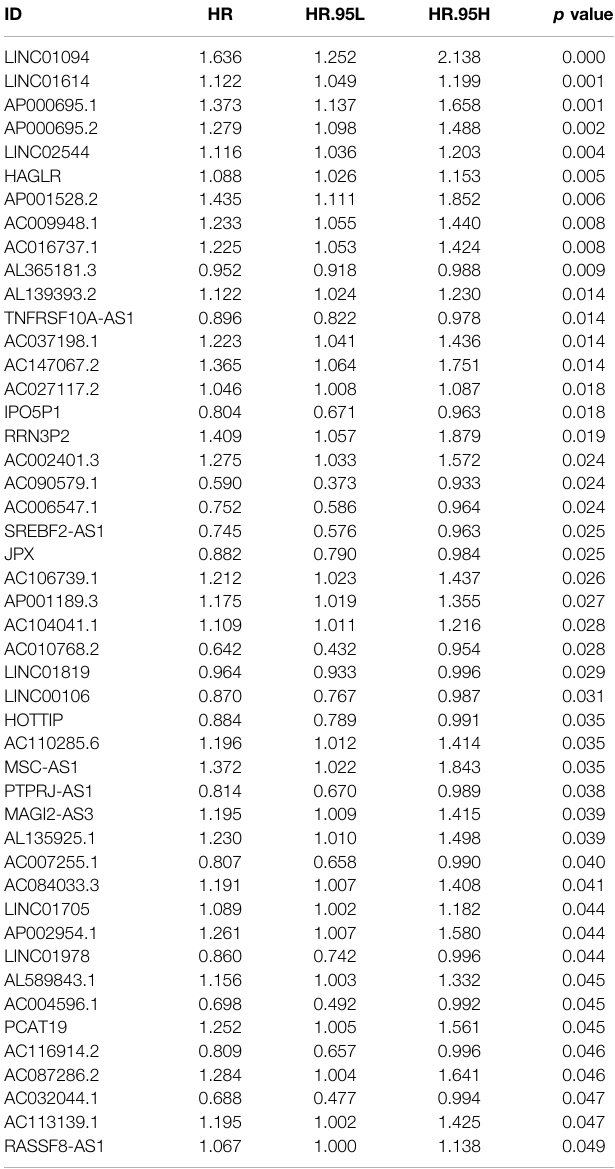
TABLE 1 | Prognosis-related CMLs identi fi ed by the univariate Cox regression analysis. ID HR HR.95L HR.95H p